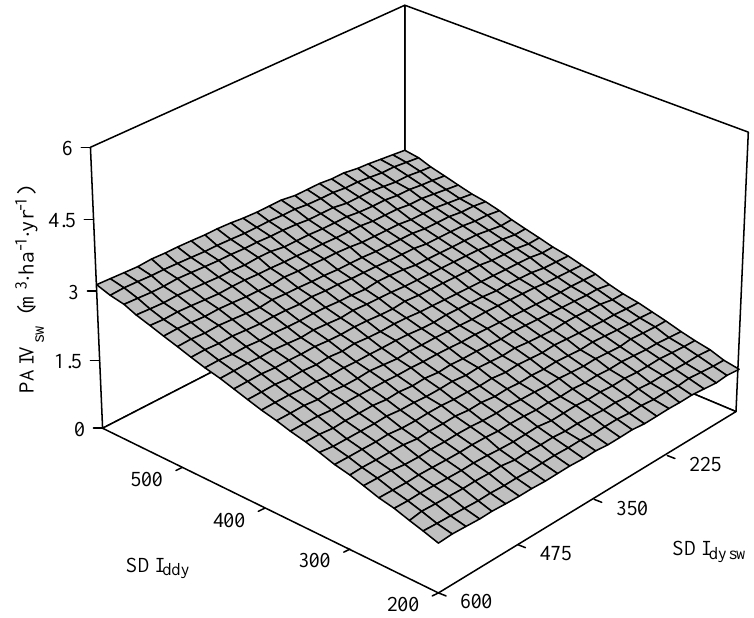
Figure 4. White spruce PAIV as a function of spruce SDI (SDI dysw ) and deciduous SDI (SDI dyd ); (HT sw and HT aw held constant). Model: PAIV sw = 0.001 × SDI dyd0.99 × SDI dysw0.06 × HT sw0.32 × HT aw0.15 .